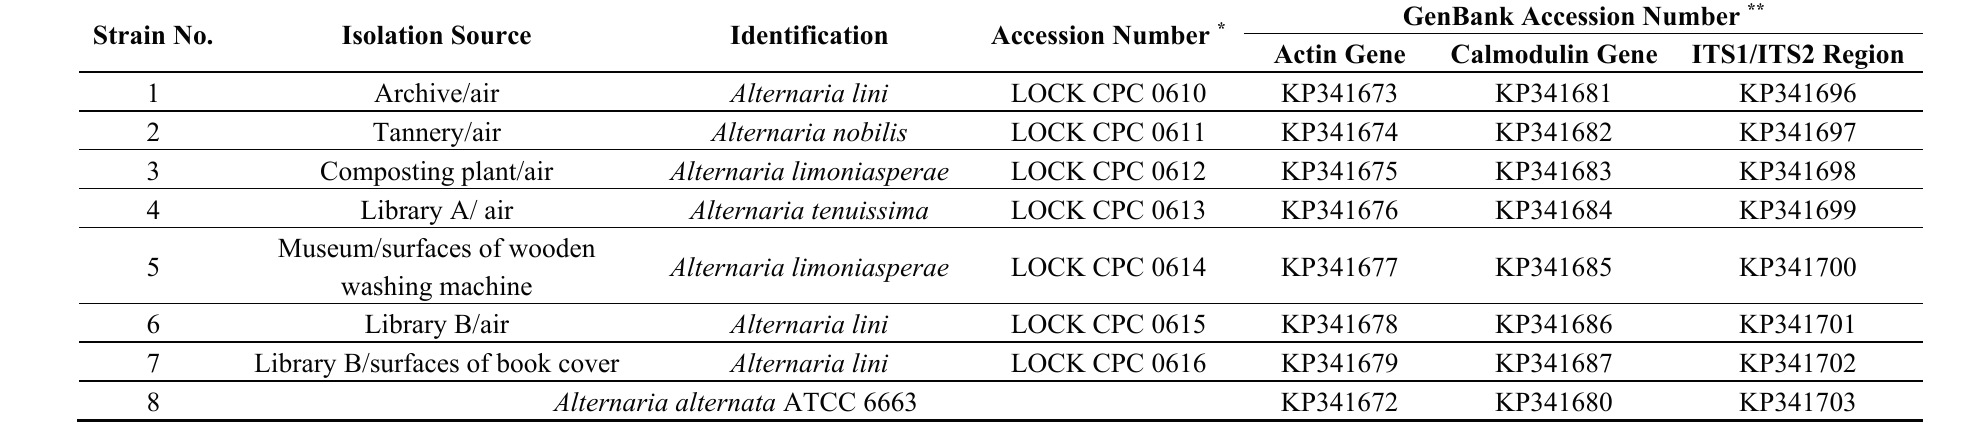
Table 3. Identification and characteristic of tested Alternaria